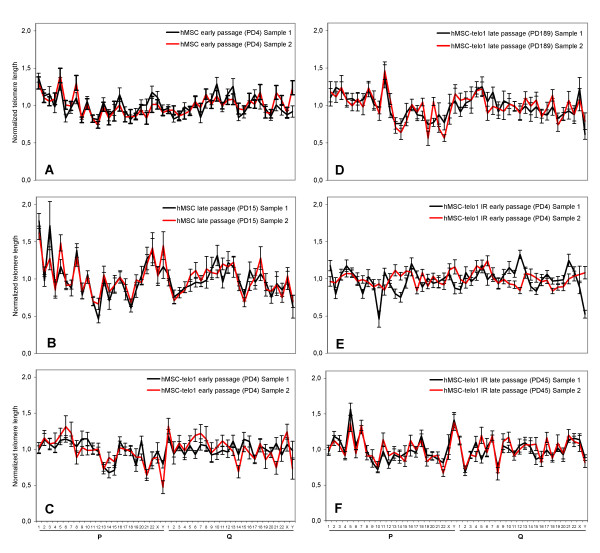
Telomere profiles. In each figure two double samples are compared. X-axis describes the chromosome arm no. and the Y-axis describes the corresponding telomere length for sample 1 (black) and sample 2 (red). Errorbars illustrates S.E.M. Each figure corresponds to one of the comparisons done in table 1. A Comparison between two samples from hMSC early passage. B Comparison between two samples from hMSC late passage. C Comparison between two samples from hMSC-telo1 early passage. D Comparison between two samples from hMSC-telo1 late passage. E Comparison between two samples from hMSC-telo1 irradiated early passage. F Comparison between two samples from hMSC-telo1 irradiated late passage.